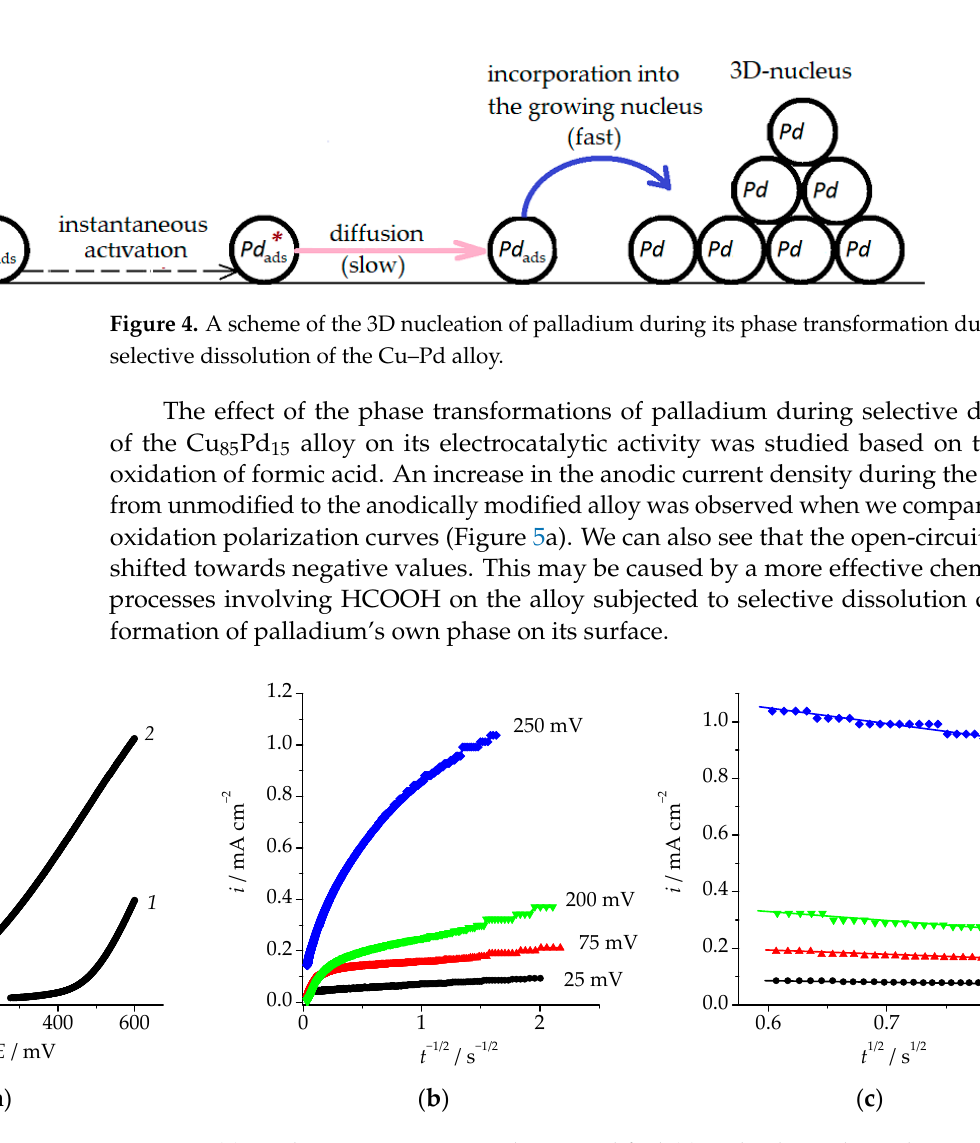
Figure 4. A scheme of the 3D nucleation of palladium during its phase transformation during an- odic selective dissolution of the Cu–Pd alloy.